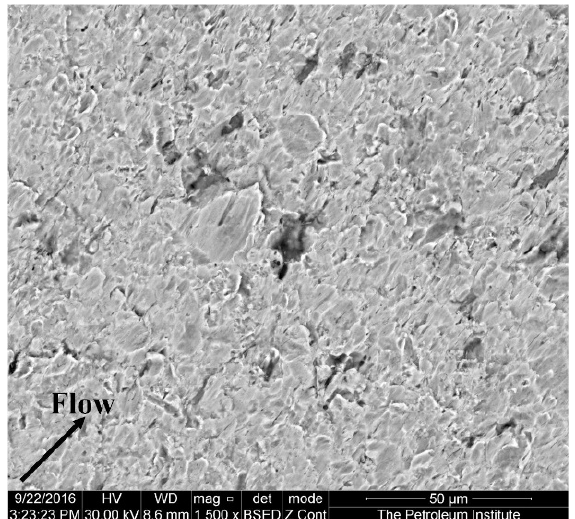
Figure 12. Surface of the specimen 2 mm away from the center after pure erosion test at 20 m/s and 600 mg/L.